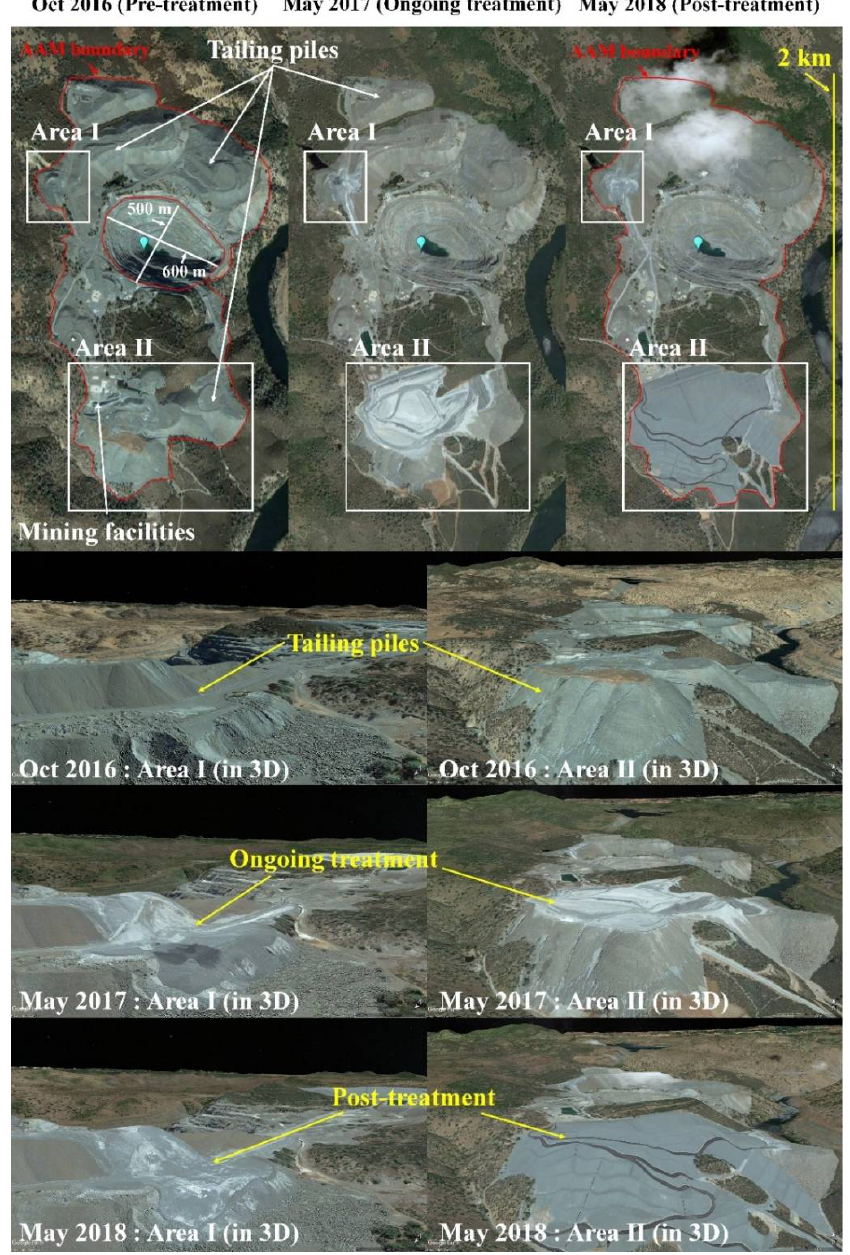
Figure 2. Time series high-resolution satellite images of the Jefferson Lake mine area from 2016, 2017, and 2018, showing remediation activities (background satellite images and zoomed-3D views are from Google Earth Pro). Two tailing piles in Areas I and II are the remediation sites. AAM and the open-pit boundaries are presented by red lines in the